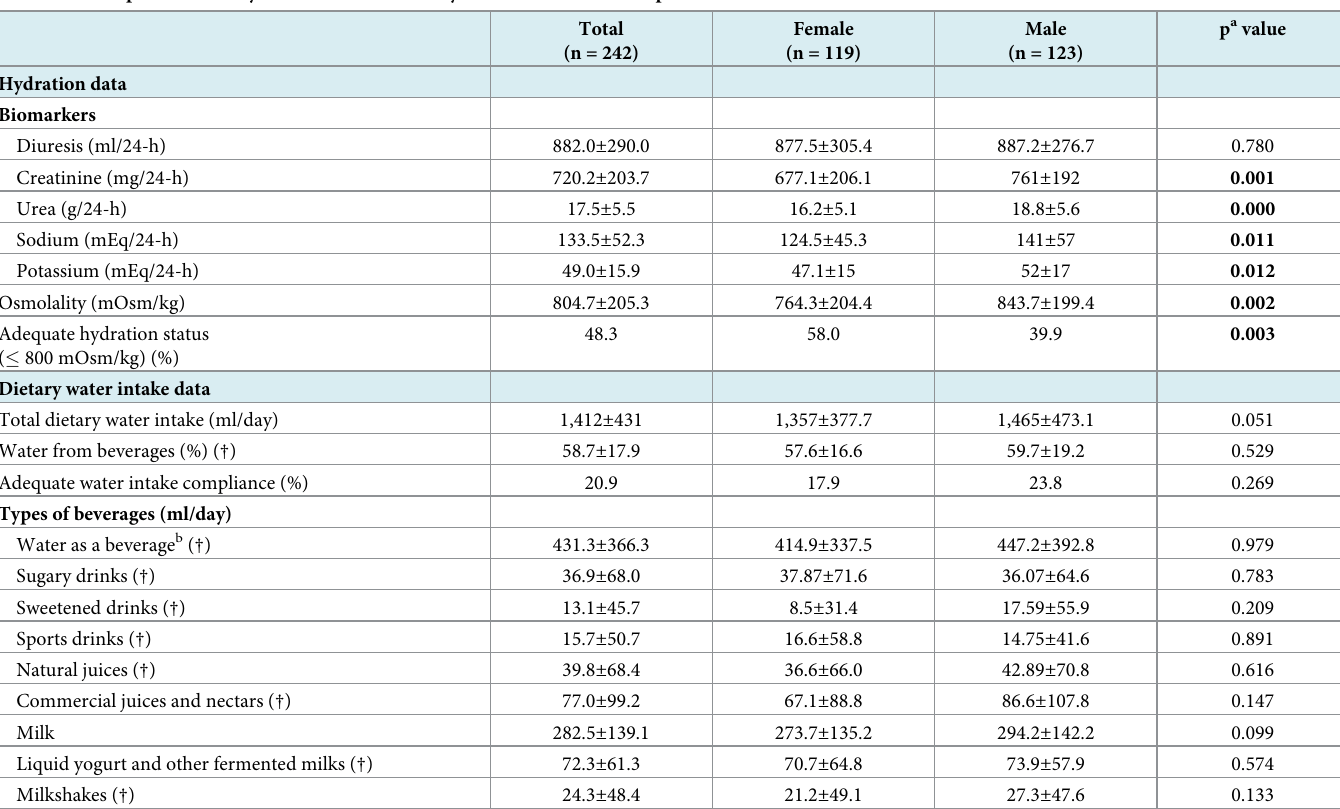
Table 2. Descriptive table of hydration data and dietary water intake of the